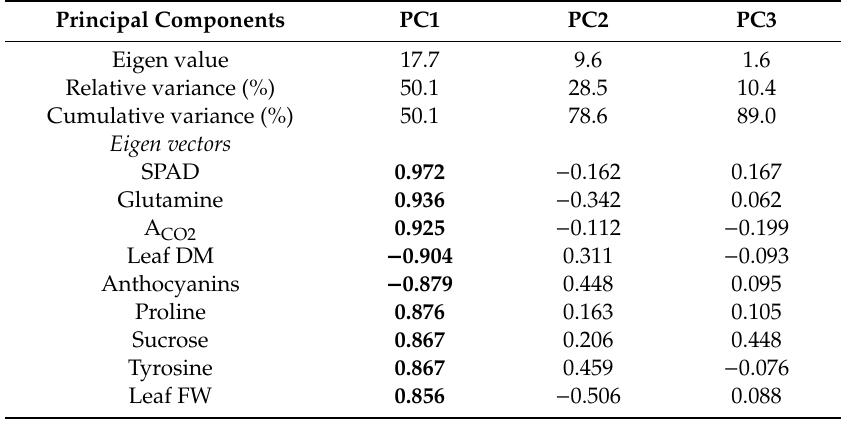
Table 6. Eigenvalues, relative and cumulative percentage of total variance, and correlation coe ffi cients for each morpho-physiological, biochemical, and nutritional jute traits with respect to the three principal components (PC1, PC2, and PC3). Boldface factor loadings are considered highly